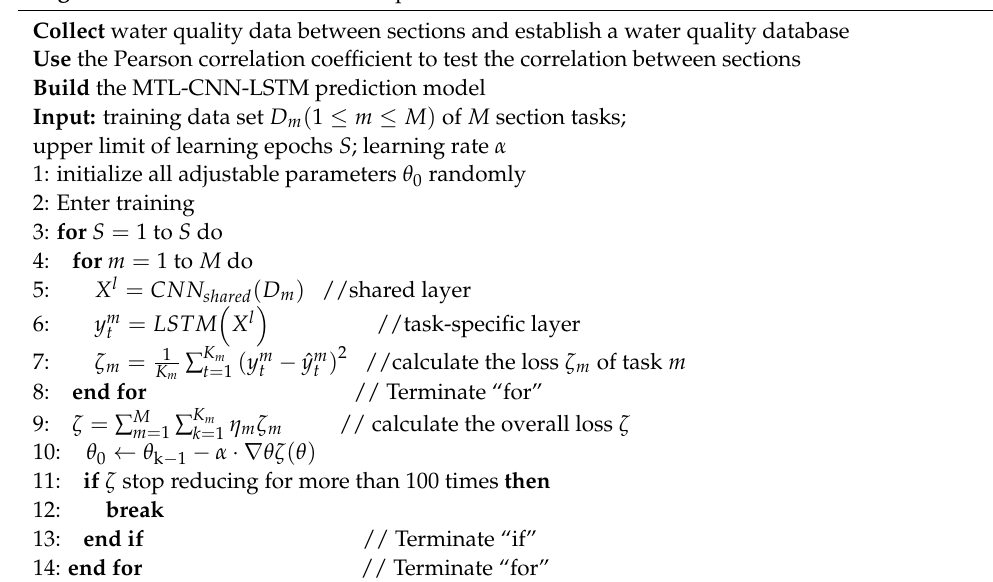
Algorithm 1: The MTL-CNN-LSTM prediction method